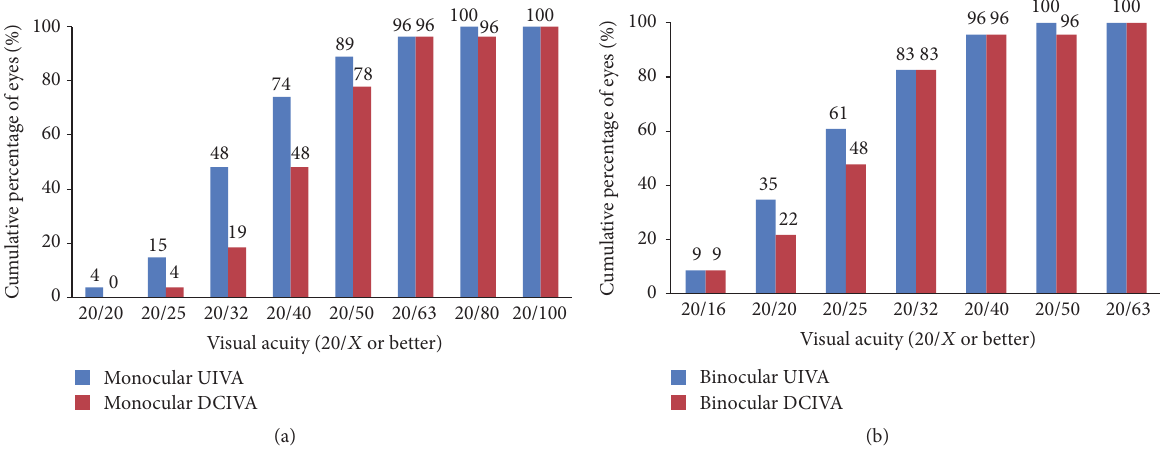
Figure 3: Monocular (operated eyes) and binocular uncorrected intermediate visual acuity (UIVA) and distance-corrected intermediate visual acuity (DCIVA) at 67 cm at the last visit.